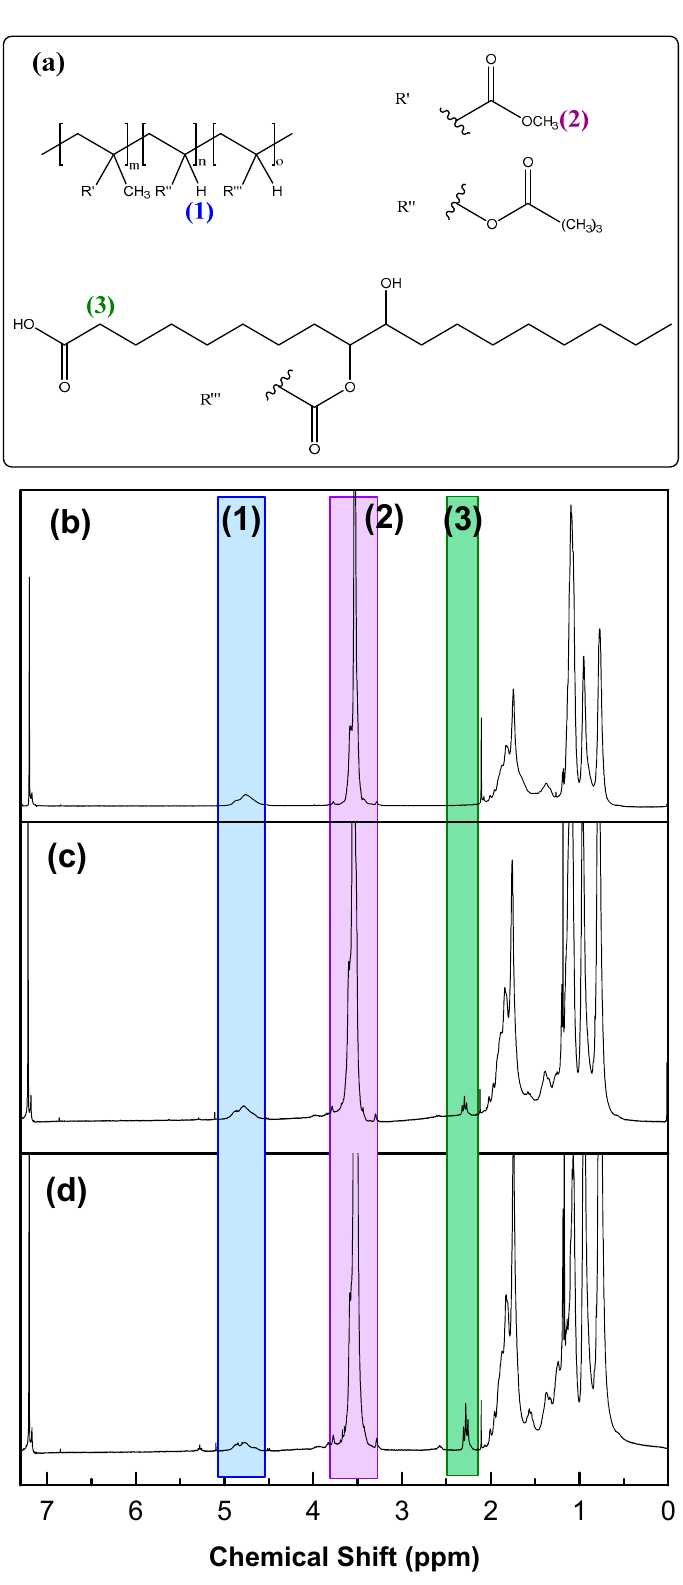
Figure 4. ( a ) Structural representation of the MMA/VPi/AFA terpolymer; 1 H ‐ NMR spectrum of ( b ) poly(methyl methacrylate ‐ co ‐ vinyl pivalate), ( c ) MMA/VPi/AFA terpolymer with 5 wt% of acrylated fatty acids (TAFA5_d), and ( d ) MMA/VPi/AFA terpolymer with 10 wt% of acrylated fatty acids and fatty acid (TAFA10_d). The numbers (1), (2), and (3) in the figures correspond to the hydrogen of vinyl pivalate, methyl methacrylate, and acrylated fatty acid, respectively.